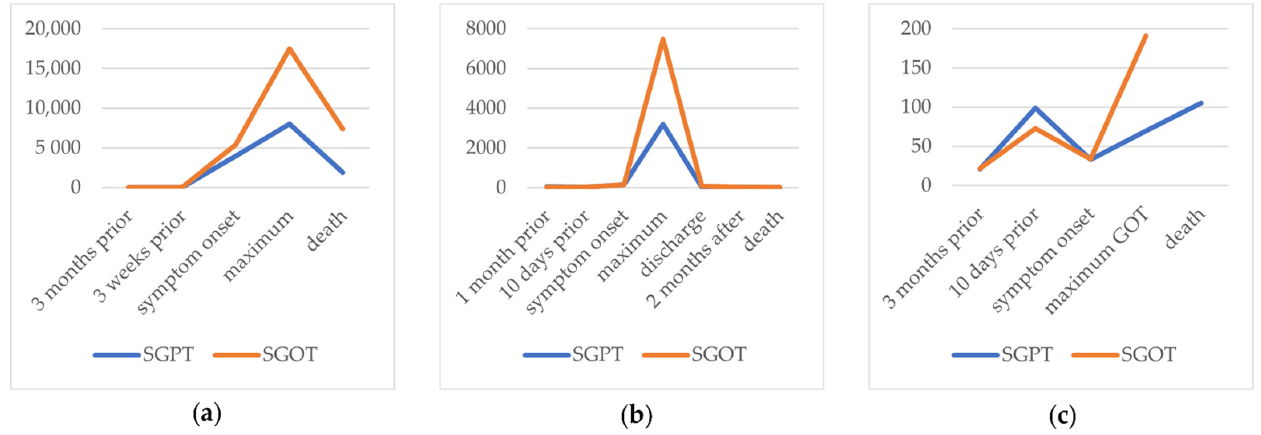
Figure 1. SGPT and SGOT (U/L) presented over time course for ( a ) case 1, ( b ) case 2, and ( c ) case 3. Initially, we suspected a GvHD of the liver and administered 250 mg of prednisolone. Other differential diagnoses for viral hepatitis were excluded (Table 3); however, HAdV DNA was detected in blood by real-time polymerase chain reaction (PCR) (Table 4; for primer, see Table S1). Genotyping in the reference lab revealed species C, type 5. In addi- tion to HAdV hepatitis, the patient became symptomatic for pneumonia during inpatient stay and was respiratory insufficient when he was administered to the ICU. We, therefore,